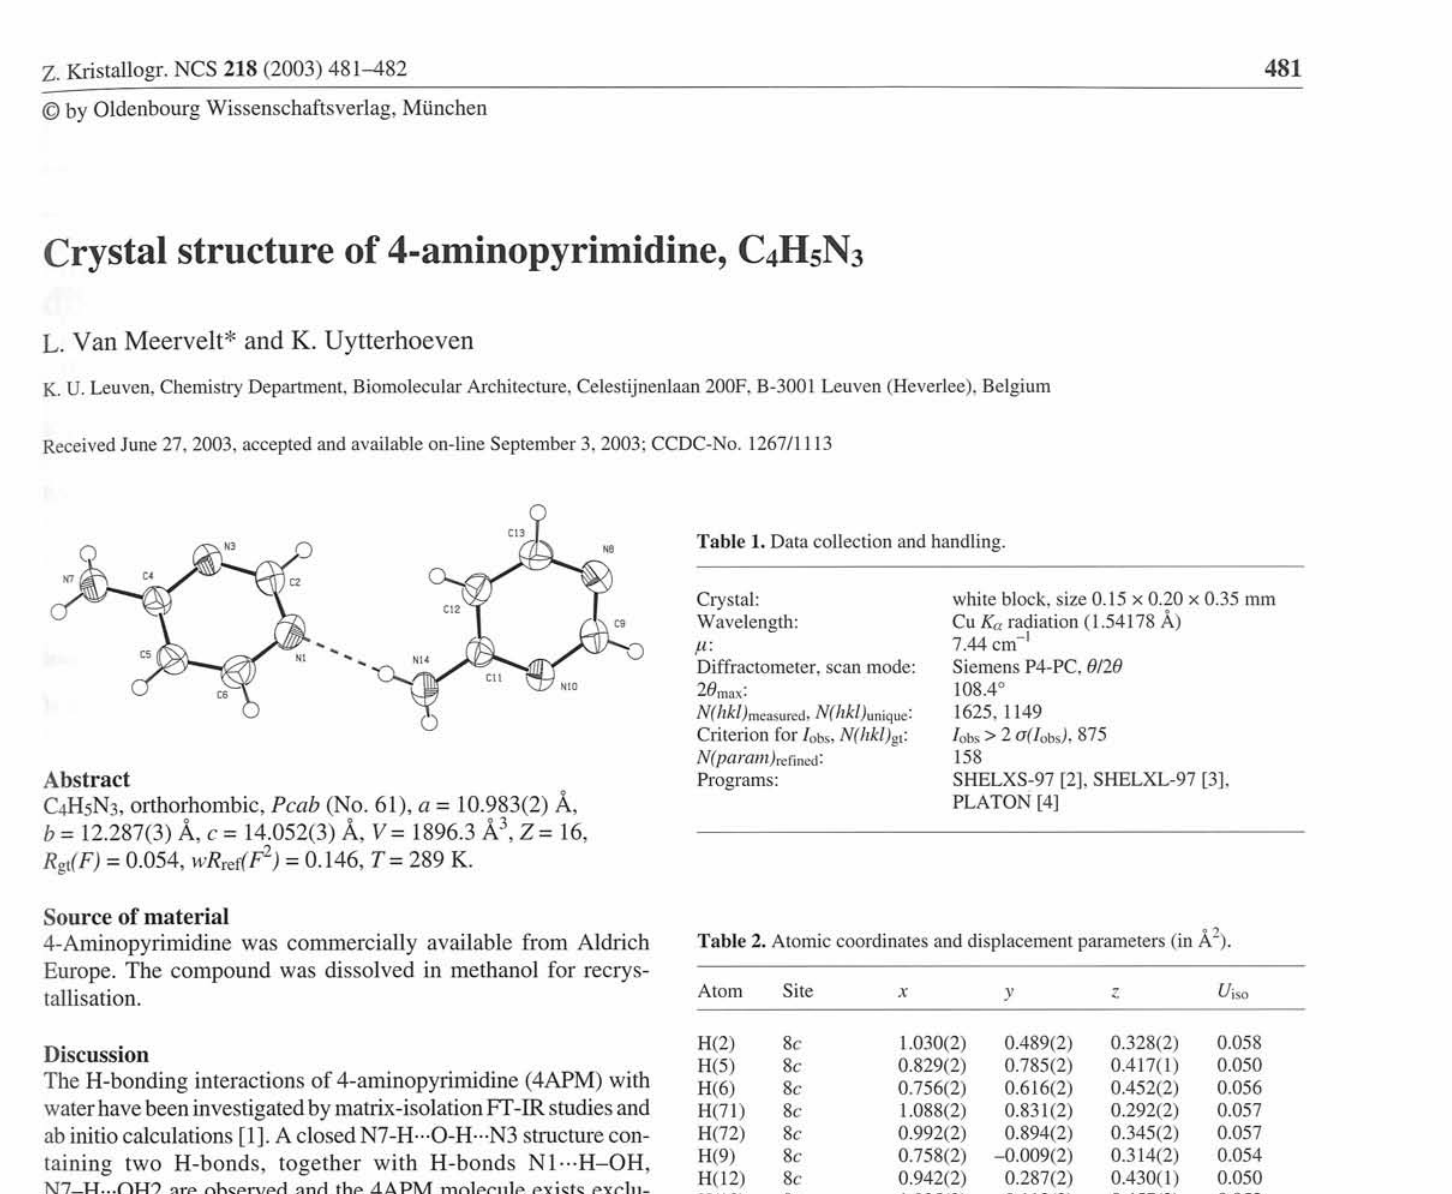
Table 3. Atomic coordinates and displacement parameters (in Â